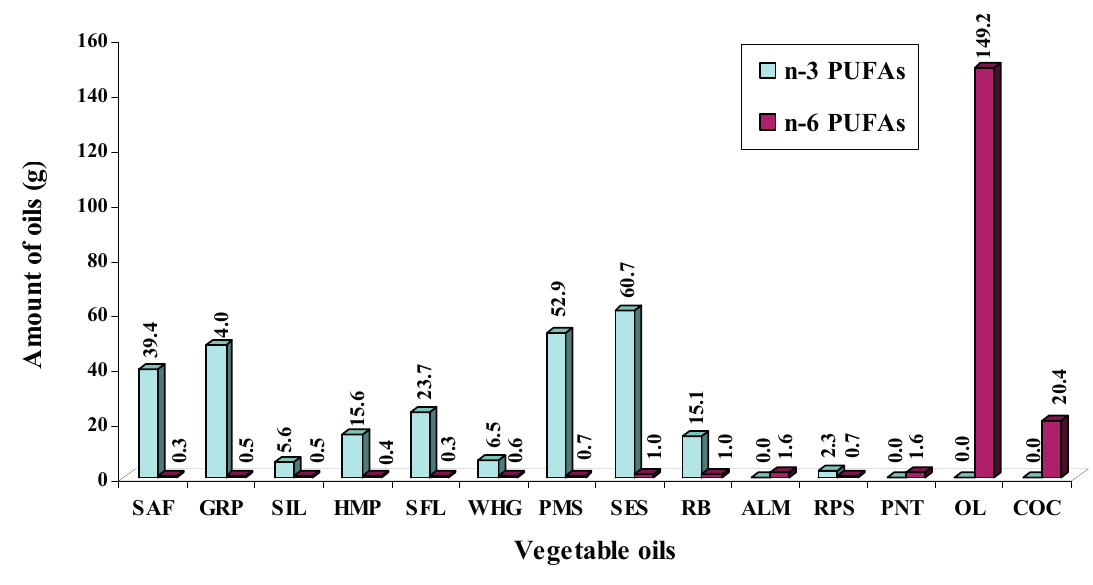
Figure 2. Oil amounts (g) needed to cover recommended energy daily intakes of n-3 PUFAs and n-6 PUFAs calculated from their maximal recommended daily values (E RDI